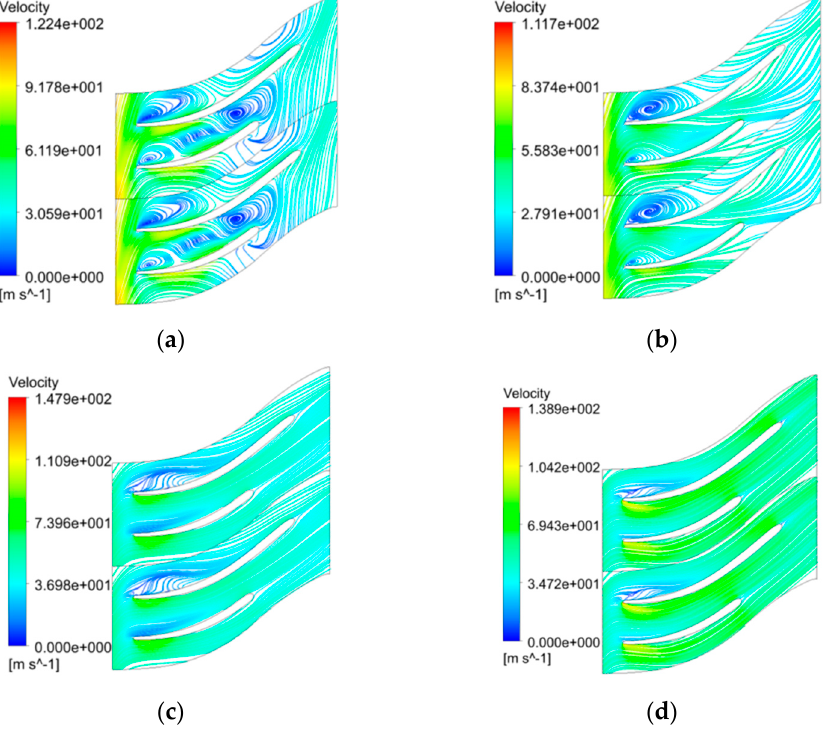
Figure 12. Streamline distribution of splitter impeller SP15 under off-design conditions: ( a ) Q/Q d = 0.6; ( b ) Q/Q d = 0.8; ( c ) Q/Q d = 1.2; ( d ) Q/Q d = 1.4.